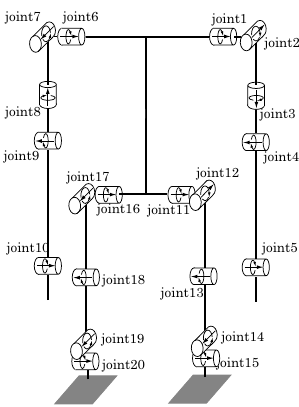
Figure 8 Structure of Gorilla Robot II.